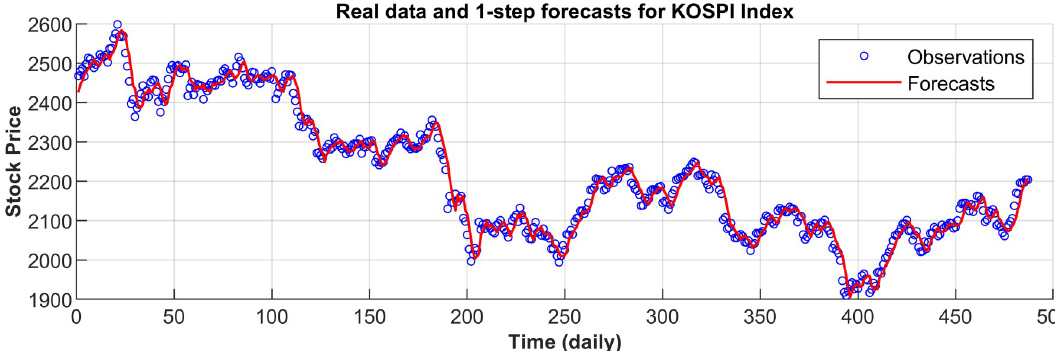
Fig 5. 1-step forecasts of the nPRM and market values for Korea KOSPI.